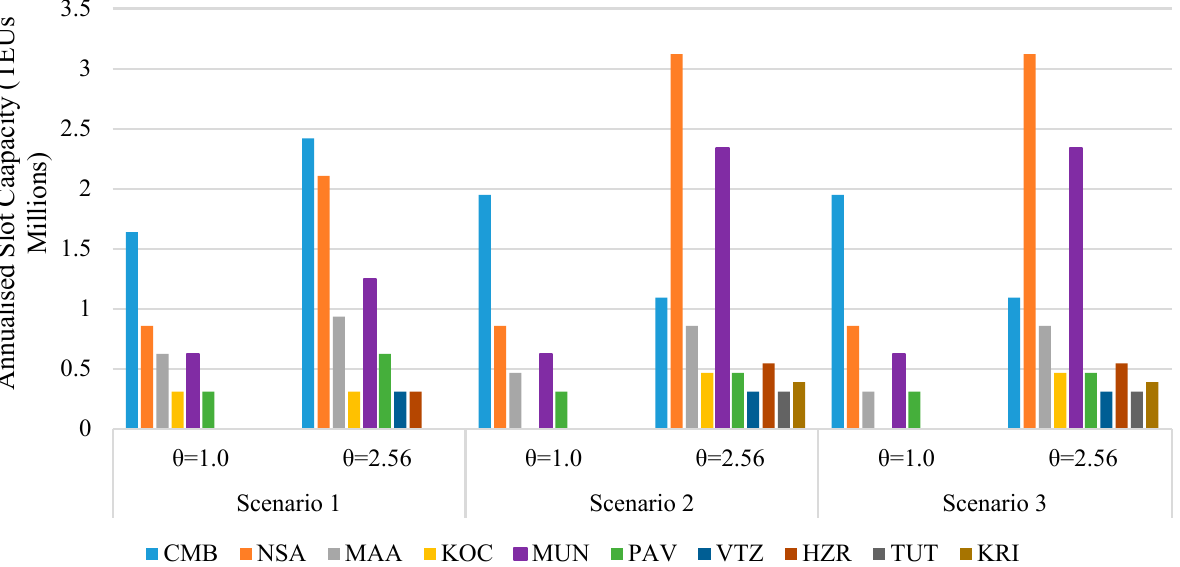
Figure 2. Annualized Slot Capacity of Services Calling at Indian Subcontinent ports.